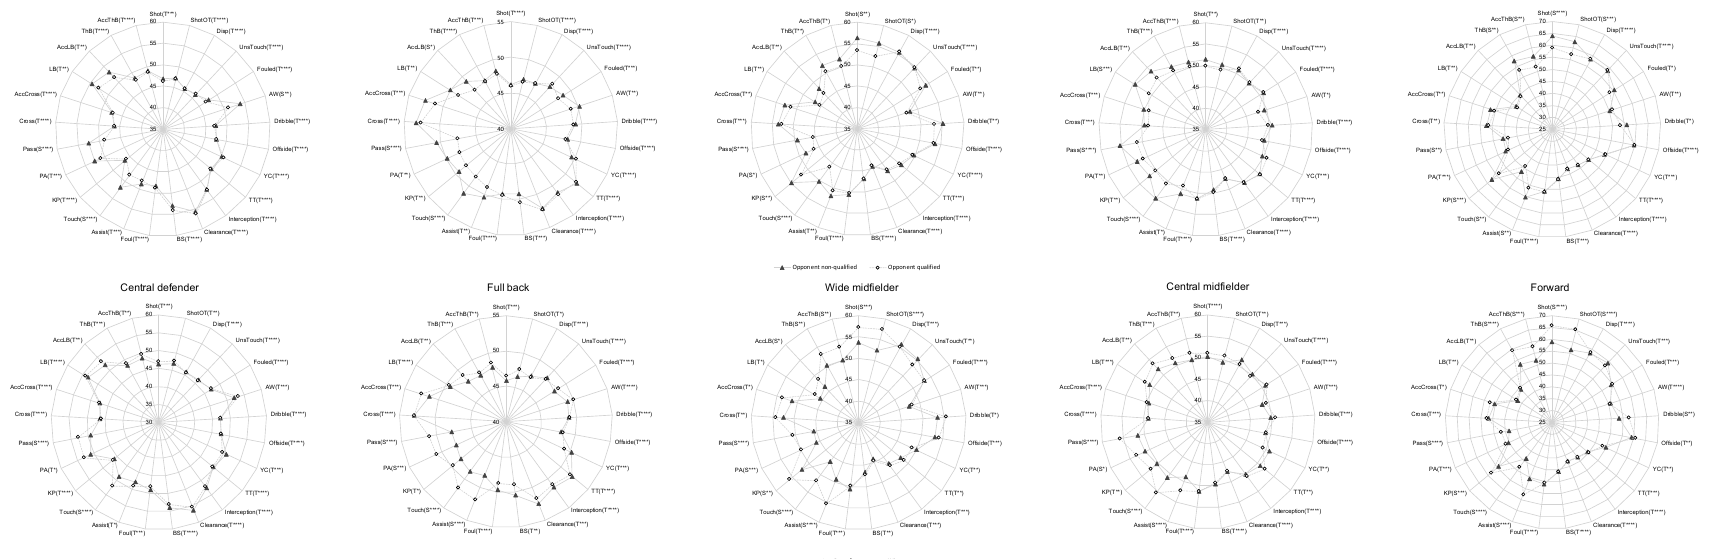
Figure 1. Comparison of the performance profiles of different position’s players under five situational variables. Notes: letters in parentheses denote the magnitude: t = trivial; s = small. Asterisks indicate the likelihood for the magnitude of the true difference in means as follows: * possible; ** likely; *** very likely; **** most likely. Abbreviations: AccCross = accurate cross pass; AccLB = accurate long ball; AccThB = accurate through ball; AW = aerial won; BS = blocked shot; Disp = player is dispossessed on the ball by an opponent-no dribble involved; KP = key pass; LB = long ball; PA = pass accuracy in %; ShotOT = shot on target; ThB = through ball; TT = total tackle; UnsTouch = Unsuccessful touch; YC = yellow card.